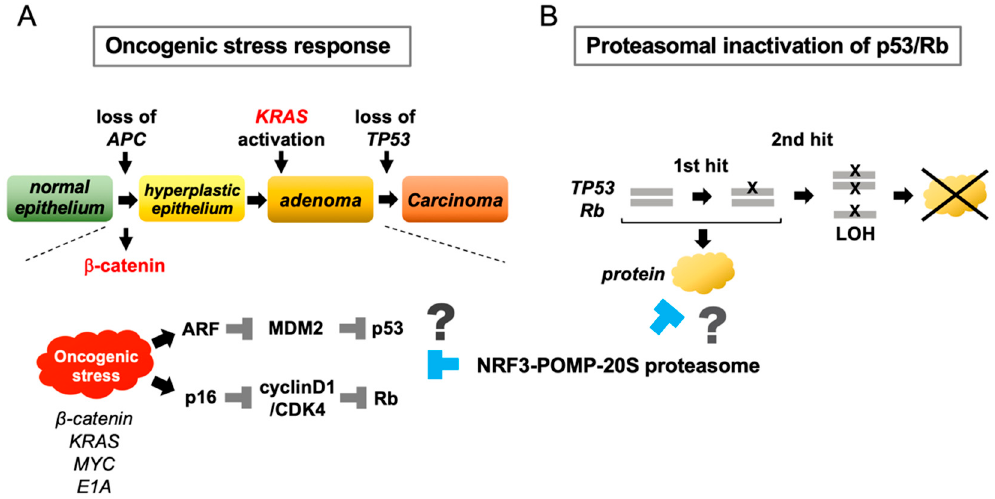
Figure 4. Conceptual hypotheses of the functional significance of NRF3 in cancer. The identification of the NRF3–POMP–20S proteasome axis allowed us to propose two conceptual hypotheses. ( A ) During the development of colorectal cancer, mutation of APC or β -catenin in the Wnt pathway is a crucial initial event that activates the oncogene β -catenin, and mutation of TP53 is the final event in carcinogenesis. In normal cells, activation of individual oncogenes, namely, “oncogenic stress“, activates p53 and Rb by stimulating the tumor suppressors ARF and p16, leading to cell cycle arrest and apoptosis. This response of normal cells confers cytoprotection against oncogenic stress. The NRF3–POMP–20S proteasome axis may eliminate the oncogenic stress response in normal cells to enable tumorigenesis. ( B ) The NRF3–POMP–20S proteasome axis represses the biological functions of p53 and Rb via